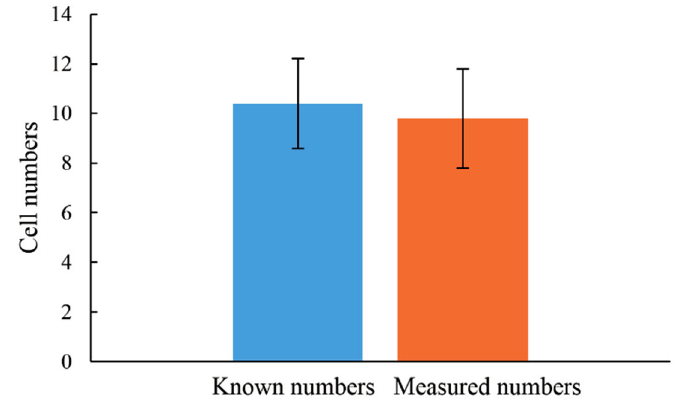
Figure 4. The detection signals of micro-droplets containing different levels (1, 2, 4, 8 and 16 cells/micro-droplet) of ( a ) OEC-M1 cells; ( b ) leukocytes; and ( c ) The quantitative relationship between the detection signals and the cell (OEC-M1 cells and leukocytes) number in each micro-droplet. The fluorescence detection was carried out after 3 h static incubation. The results are displayed as the mean ± the standard deviation of three separate experiments. Significant differences are expressed as ★ ( p < 0.05).